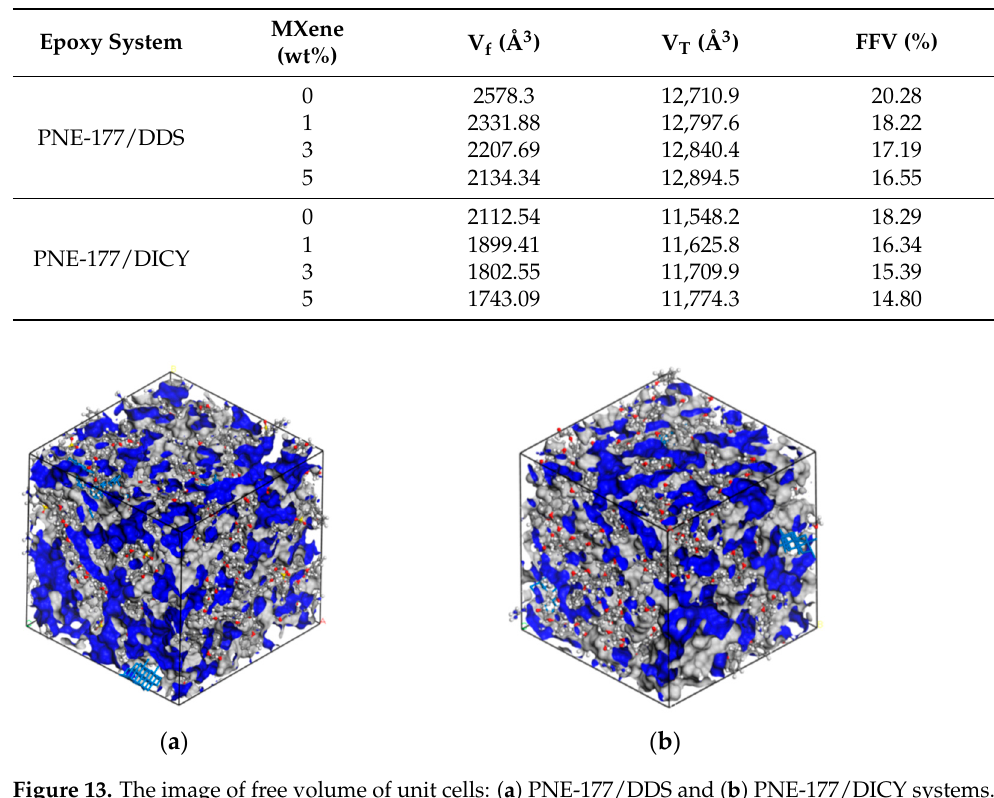
Figure 13. The image of free volume of unit cells: ( a ) PNE-177/DDS and ( b ) PNE-177/DICY systems. Table 5. The free volume parameters of PNE-177/DDS and PNE-177/DICY systems.